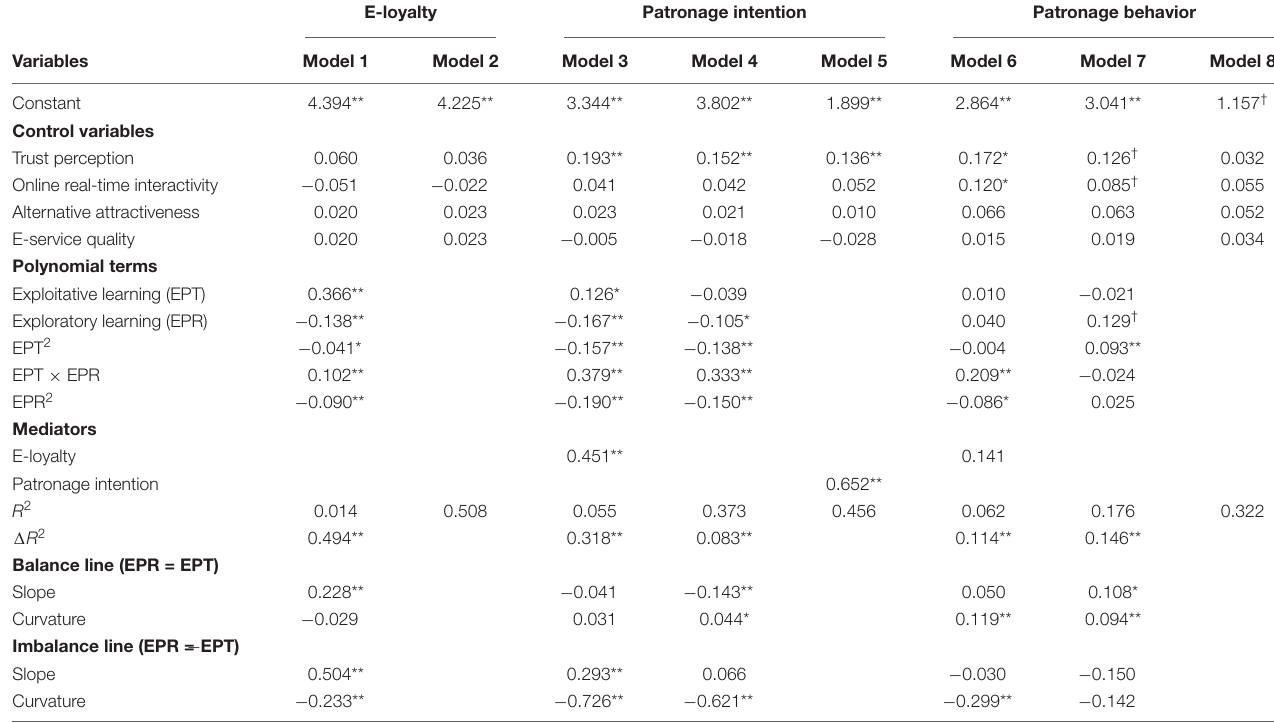
TABLE 4 | Polynomial regression results.